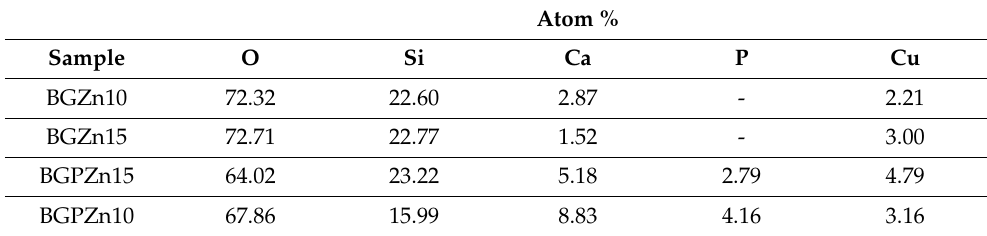
Table 4. EDX analysis of the samples with